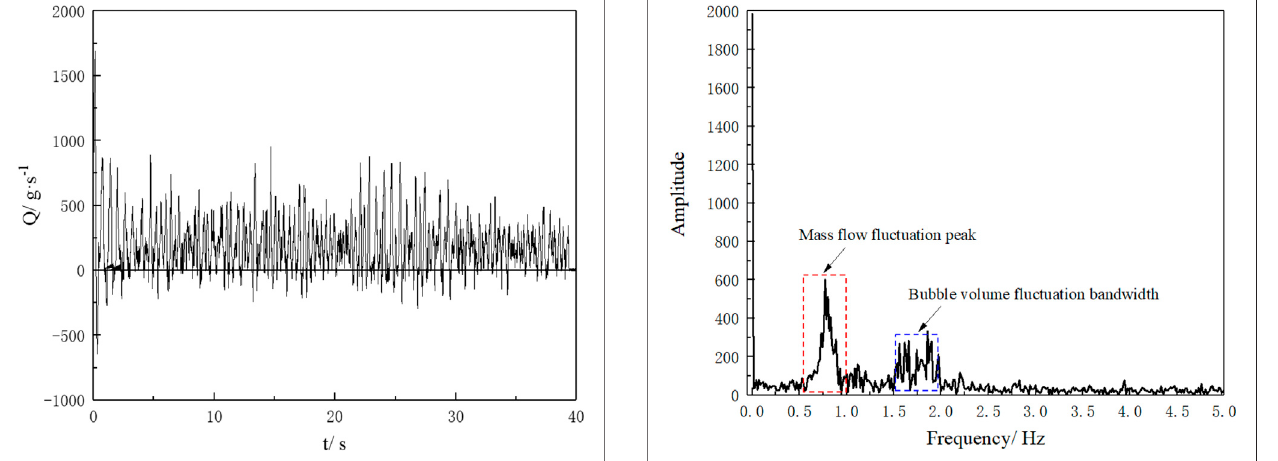
FIGURE 8 | Fluctuation of discharge fl ow rate during the whole discharge process.